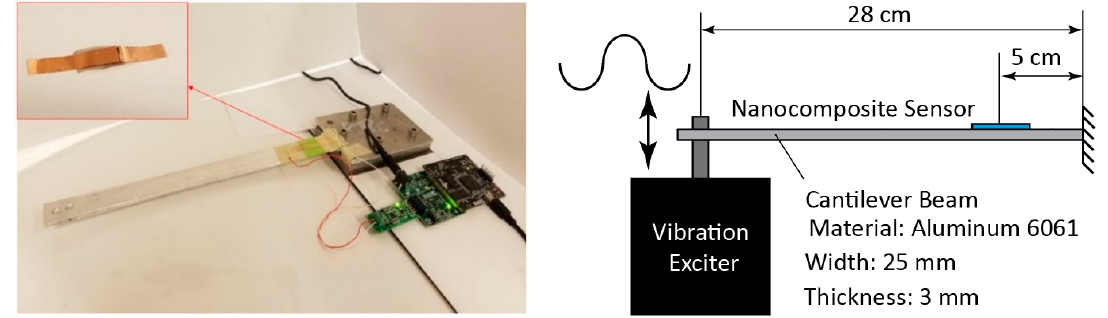
Figure 8. The experimental setup used in this study.